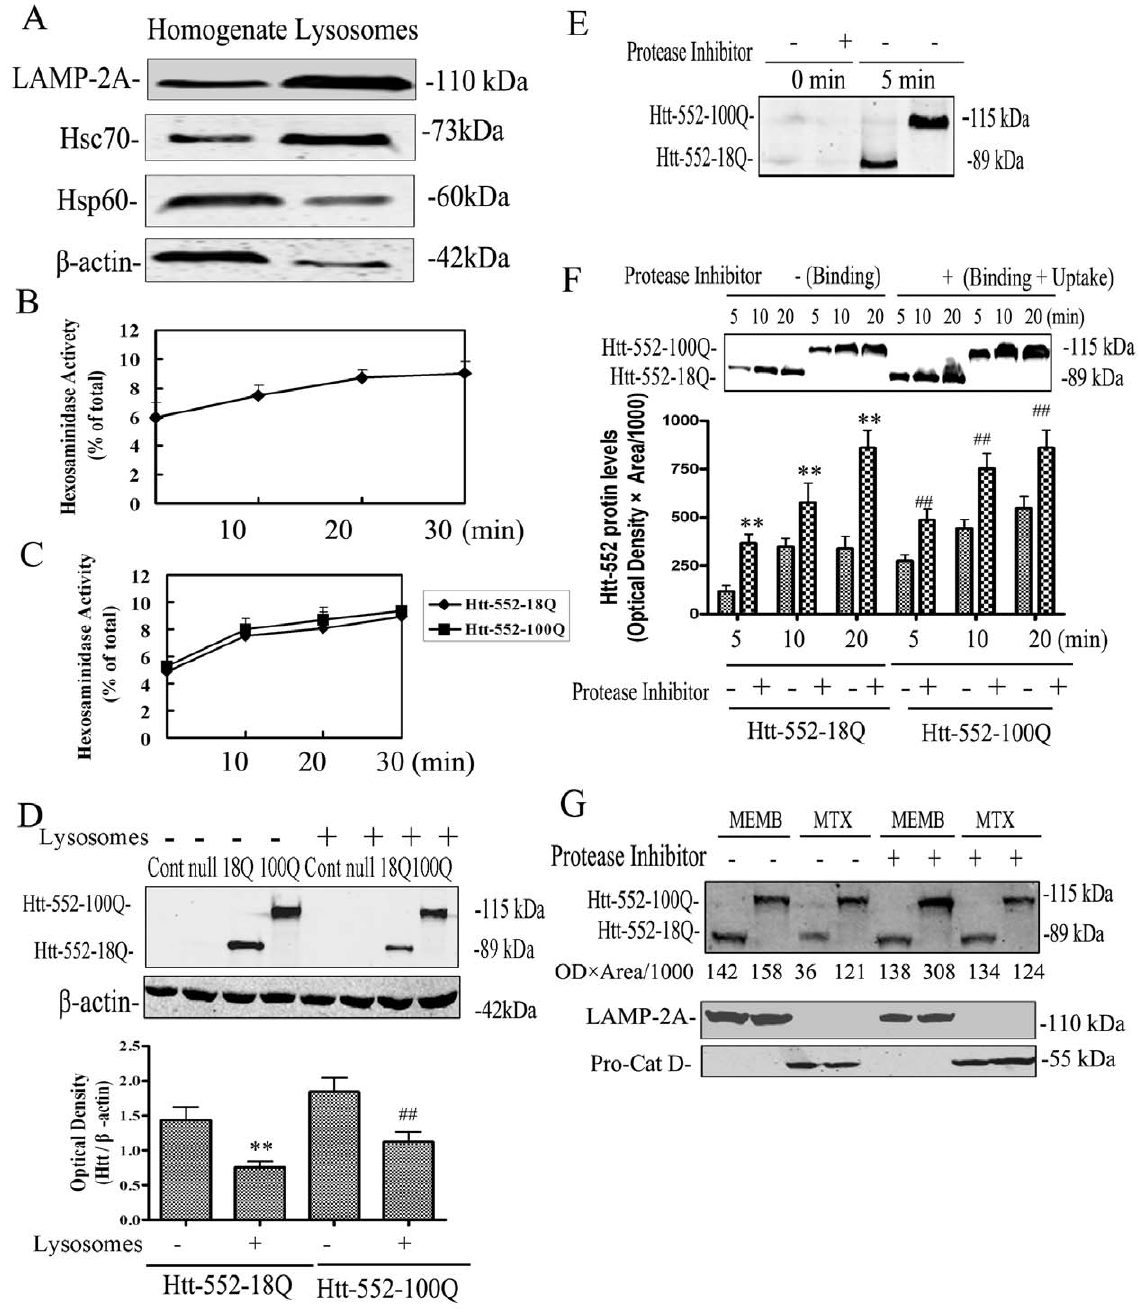
Figure 5. Degradation of Htt-552 by lysosomes. (A) The purity of the isolated lysosomes. Total cellular homogenates and lysosomal fraction (30 m g of proteins) were subjected to SDS-PAGE and immunoblotting for the indicated proteins. Actin was shown as a marker of cytoplasm. Hsp60 was shown as a marker of mitochondrial. LAMP-2A and Hsc70 were shown as markers of lysosomes. (B) The integrity of the isolated lysosomes. The release of b - hexosaminidase from lysosomes was indicated with incubation of lysosomes with para-nitrophenylphosphate (PNPP). The reaction was terminated with 0.25 mol/LNaOH.Releaseofalllysosomal b -hexosaminidasewasinducedbyincubationwith0.1%TritonX-100.Valuesof b -hexosaminidaseactivityareexpressedaspercentageoftotalactivityinthelysosomalfractionattime 0, 10, 20 and 30 min and are means 6 SE of three independent experiments. (C) Effects of Htt-552 on lysosomal stability. The release of b -hexosaminidase from intact lysosomes incubated with Htt-552-18Q or Htt-552-100Q. PC12 cells were transfected with Htt-552 for 48 h. Cell lysates were used as Htt-552-riched lysates. The lysates containing Htt-552 were incubated with isolated lysosomes and the lysosomal b -hexosaminidase activity at time 0, 10, 20 and 30 min was determined. Release of all lysosomal b -hexosaminidase from the same batches of lysosomes was induced by incubation with 0.1% Triton X-100. The values are means 6 SE of three independent experiments. (D) Effects of lysosomes on the degradation of Htt-552. PC12 cells were trasfected with Htt-552 as described above and cell lysates were incubated with isolated lysosomes. The degradation of Htt-552-18Q and Htt-552-100Q after incubating with intact lysosomes was assessed with Western blot analysis. Values are the mean 6 SE of three independent experiments. **P , 0.01 (compared with Htt-552-18Q without treatment); ## P , 0.01 (compared withHtt-552-100Qwithouttreatment). (E) Associationofincreasing Htt-552withisolated lysosomes untreated(Binding) or pre-treatedwithprotease inhibitors (Binding + Uptake) at 0 and 5 min. Values are the mean 6 SE of three independent experiments. (F) Association of increasing Htt-552 with isolated lysosomes untreated (Binding) or pre-treated with protease inhibitors (Binding + Uptake) at 5, 10 and 20 min. Values are the mean 6 SE of three independent experiments.